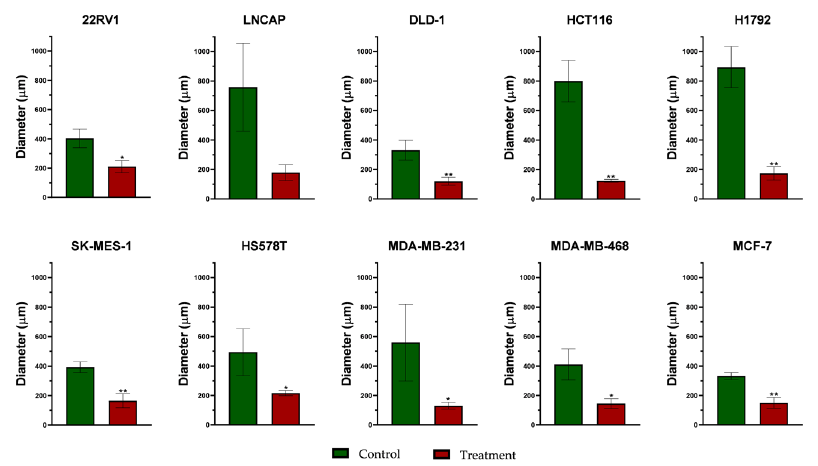
Figure 3. Colony assay evaluation on ten cancer cell lines. (Statistical analysis: unpaired t -test was applied to determine significant differences in colony numbers. * p < 0.05, ** p < 0.01).